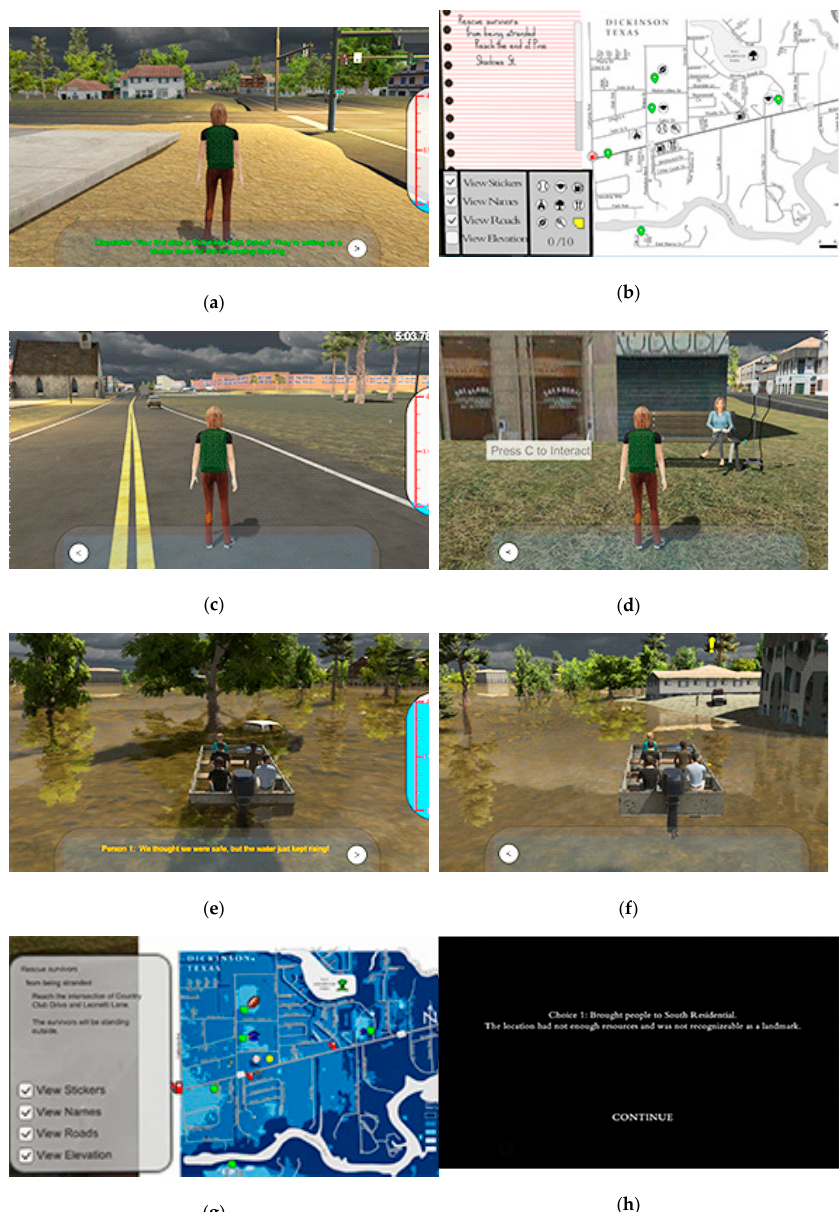
Figure 4. ( a – h ) Overview of Project Lily Pad missions: ( a ) first, the player acts as a first responder delivering supplies to key locations in the city before water levels reach flood stage; ( b ) throughout the game, the player uses several map layers as seen in this reference map; ( c ) layer of markers that players apply to the map themselves to highlight important landmarks; ( d ) the player also learns how to adjust to the needs of vulnerable populations during the pre-flood stage of the game; ( e ) as a flood occurs, they act as a member of a volunteer-run disaster relief organization, rescuing people from their flooded homes via boat; ( f ) the game player rescues people by taking them to “lily pads”, a term created by emergency responders in Galveston county during Hurricane Harvey in 2017, for areas of higher elevation minimally impacted by flooding; ( g ) game players can also review a digital elevation model (DEM) view of the flood for spatial awareness about the relationships between flood waters and topography; ( h ) after each rescue mission, the player receives feedback on the quality of the lily pads they have chosen based on the geographic information they were